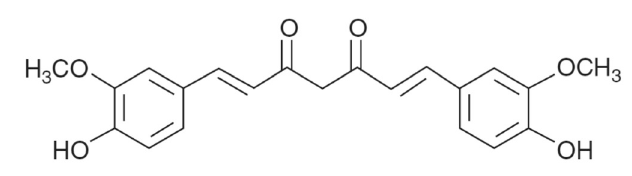
FIGURE 1 - Chemical structure of